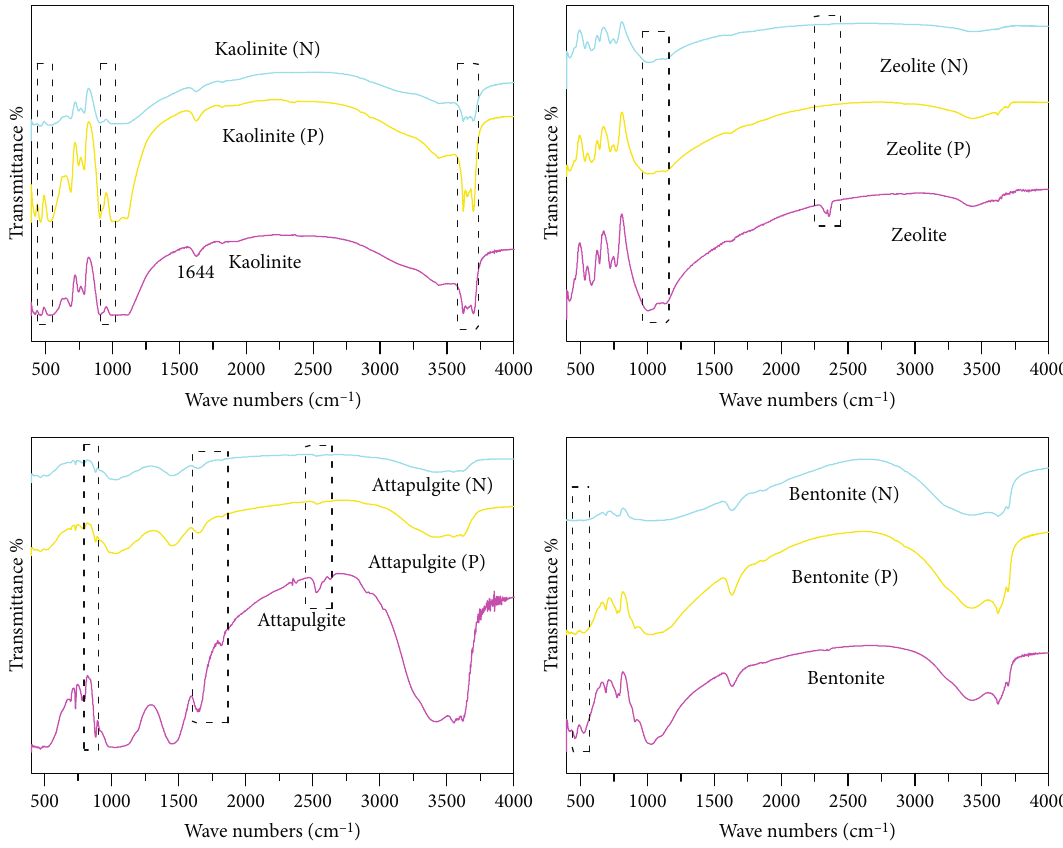
Figure 2: FTIR spectra of NCMs before and after adsorption of ammonia nitrogen (N) and phosphate